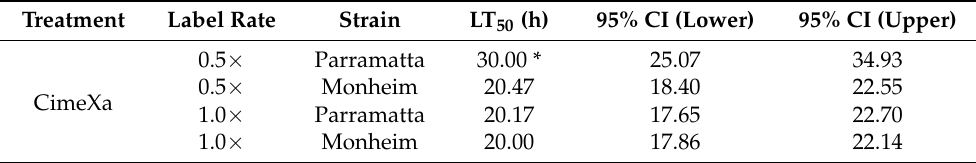
* Indicates statistically significant difference as determined by failure of the 95% confidence intervals to overlap.